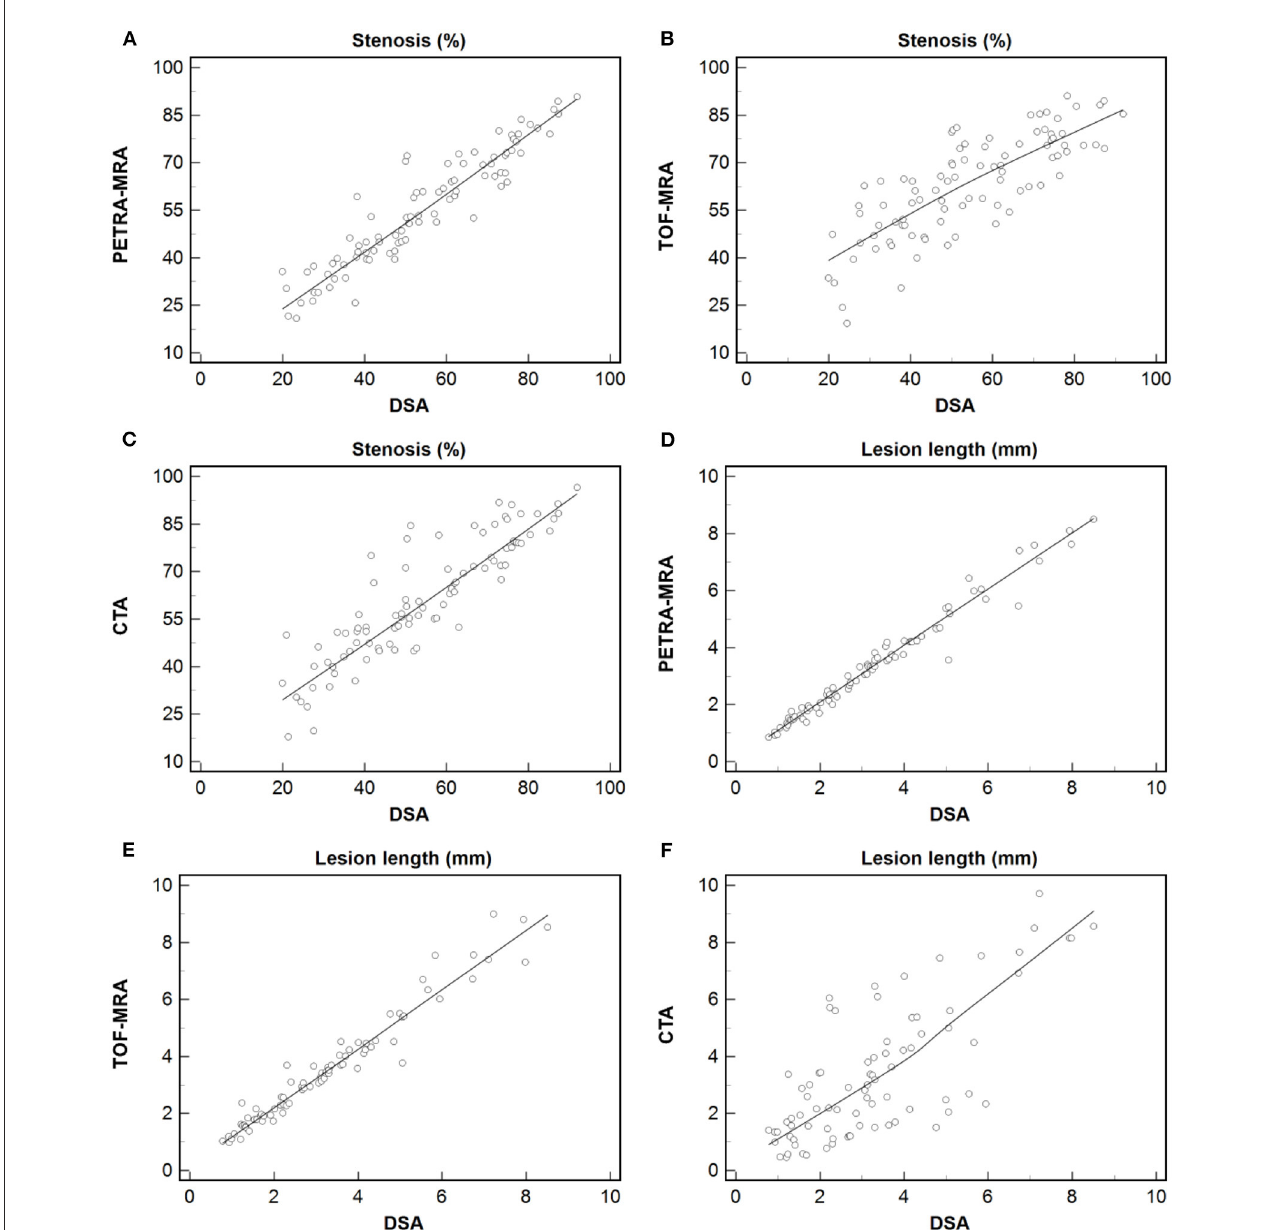
FIGURE3 Measurement of the degree of stenosis and lesion length using PETRA-MRA, TOF-MRA, or CTA vs. those using DSA. Dashed line = regression line. The greatest correlation was observed in measuring the degree of stenosis and lesion length between PETRA-MRA and DSA than between TOF-MRA and DSA, and between CTA and DSA [r (stenosis): 0.94 vs. 0.80 and 0.89; r (lesion length): 0.99 vs. 0.98 and 0.70]. (A–C) Stenosis: Spearman’s correlation analysis of PETRA-MRA, TOF-MRA, and CTA with DSA respectively. (D–F) Lesion length: Spearman’s correlation analysis of PETRA-MRA, TOF-MRA, and CTA with DSA